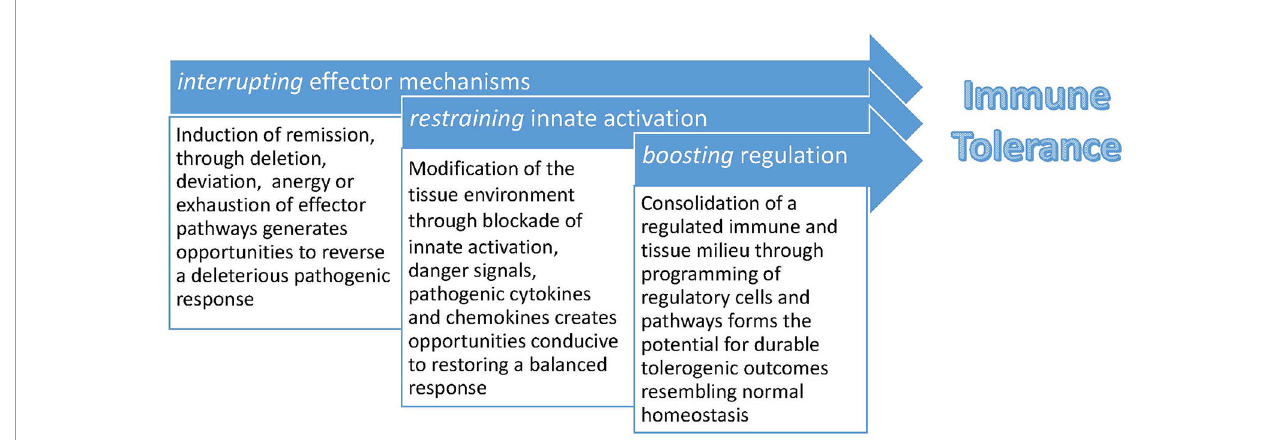
FIGURE 2 | A conceptual framework for induction and maintenance of immune tolerance. Tolerogenic therapies that focus on boosting regulatory immune responses face daunting hurdles in the form of established immunological memory and robust redundant effector activation pathways, involving both adaptive and innate immunity. Creating a host environment conducive to regulation is augmented by fi rst inducing clinical remission and decreasing tissue in fl ammation. This concept creates a practical platform for combination therapies in which short-term immunosuppressive or immunomodulatory interventions are fi rst employed, followed by emphasis on restoration of immune